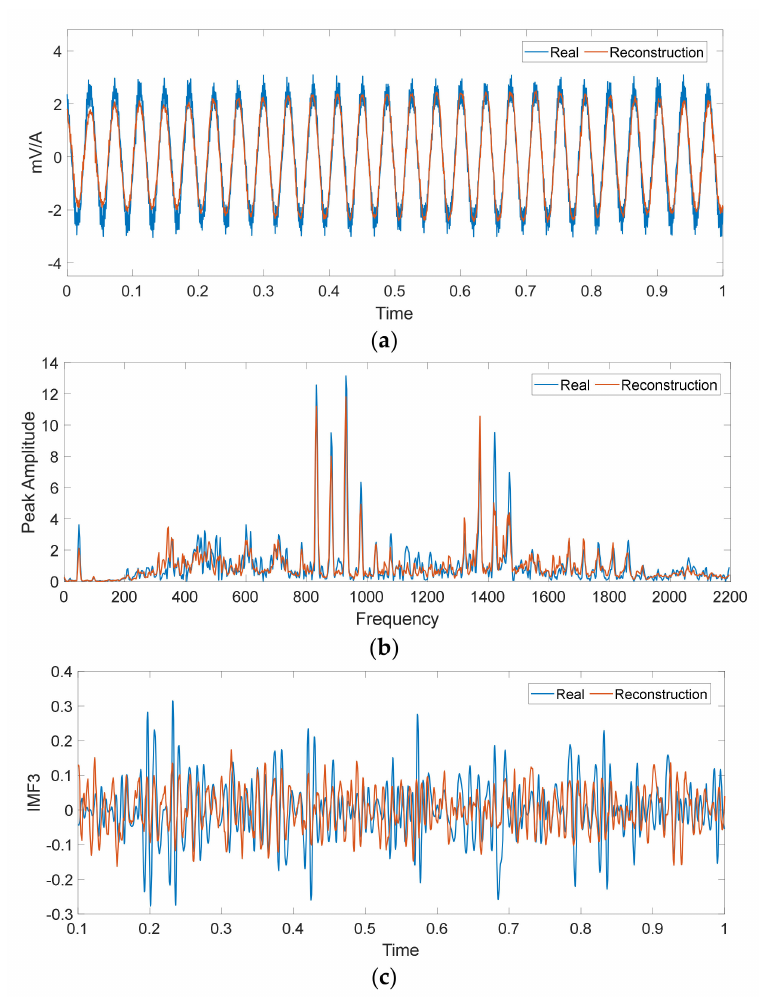
Figure 9. Comparison between the input signal and the reconstruction obtained using the DNN Stacked-SAEs-based feature extraction model for the healthy condition, ( a ) current in T-D, ( b ) vibration in F-D ( c ) one IMD for vibration in